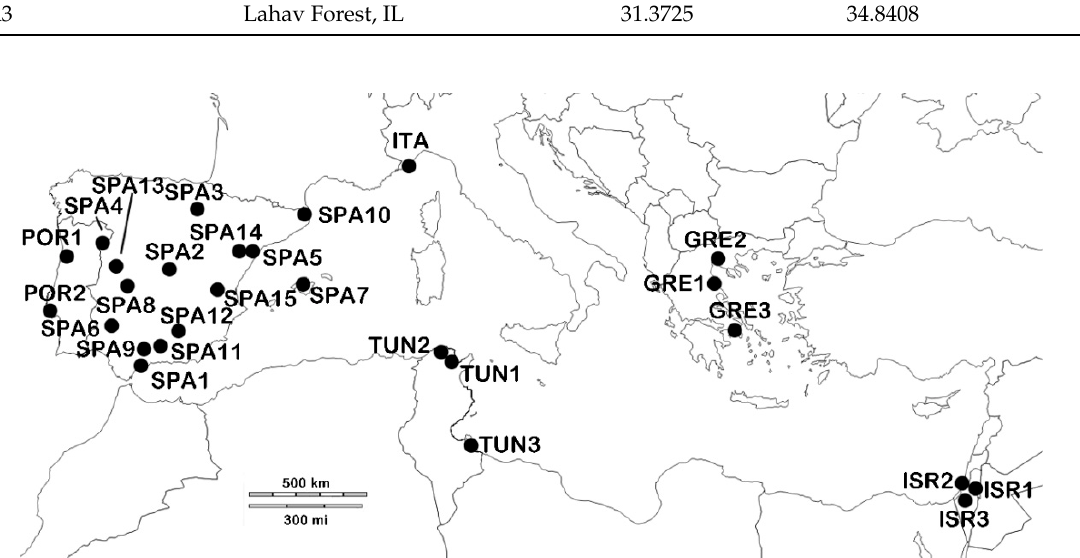
Figure 1. Map showing the Bactrocera oleae ( B. oleae ) populations sampled. Table 1. Populations of B. oleae analysed with the code assigned, locality, geographical coordinates (LAT, latitude; LONG, longitude) and sample size (N). SPA, Spain; POR, Portugal; ITA, Italy; TUN, Tunisia; GRE, Greece; ISR, Israel.